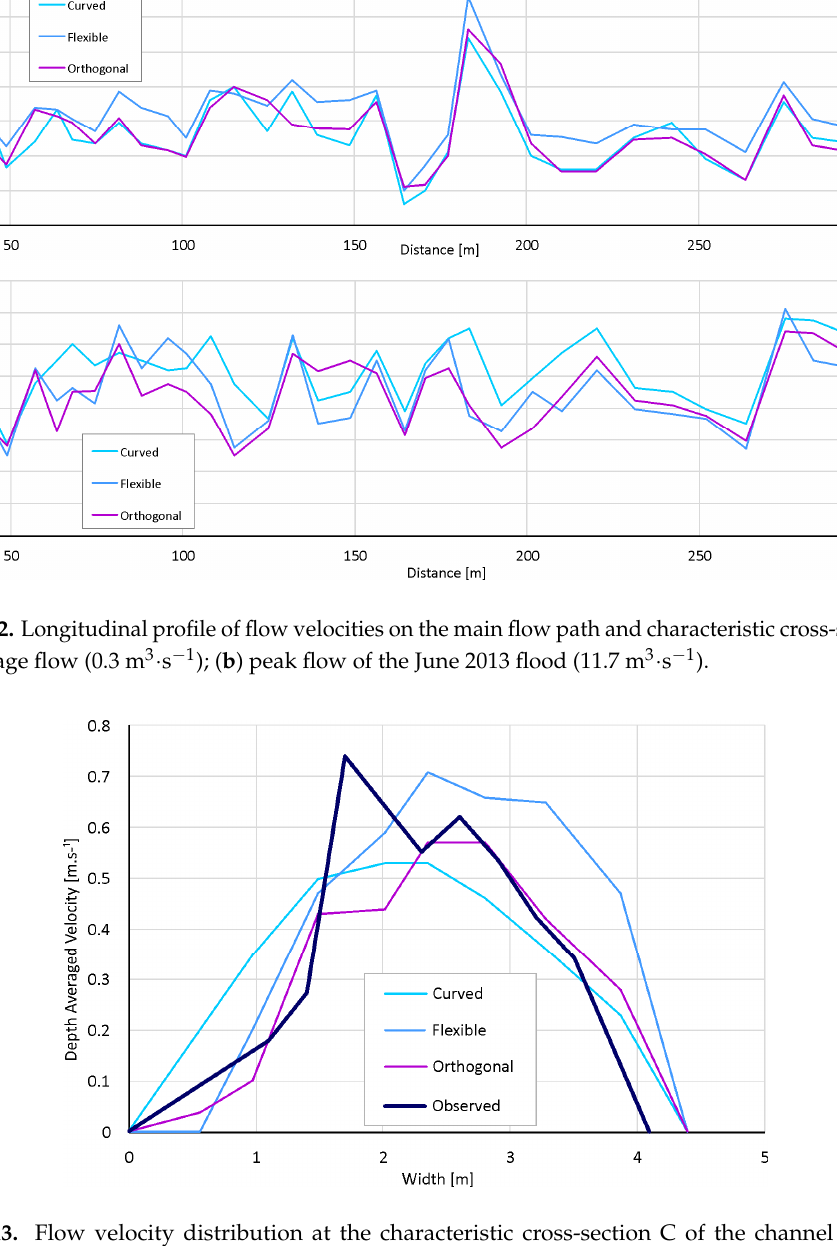
Figure 13. Flow velocity distribution at the characteristic cross-section C of the channel arch in comparison with the observed values under average hydrologic conditions.